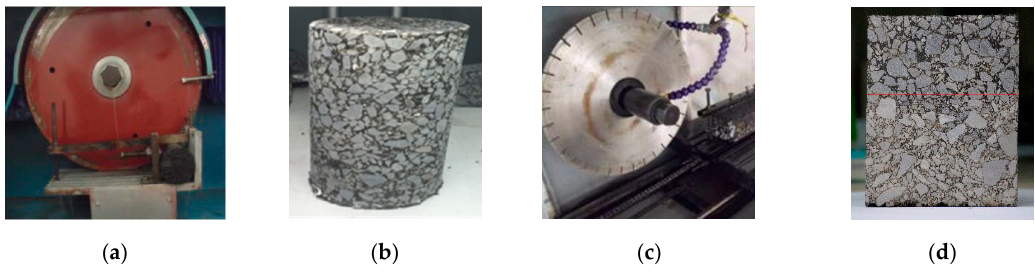
Figure 4. Preparation of the double-layer wheel tracking test specimen. ( a ) The mold for double-layer asphalt mixtures; ( b ) The compaction of the lower layer; ( c ) The compaction of a double-layer asphalt mixture.